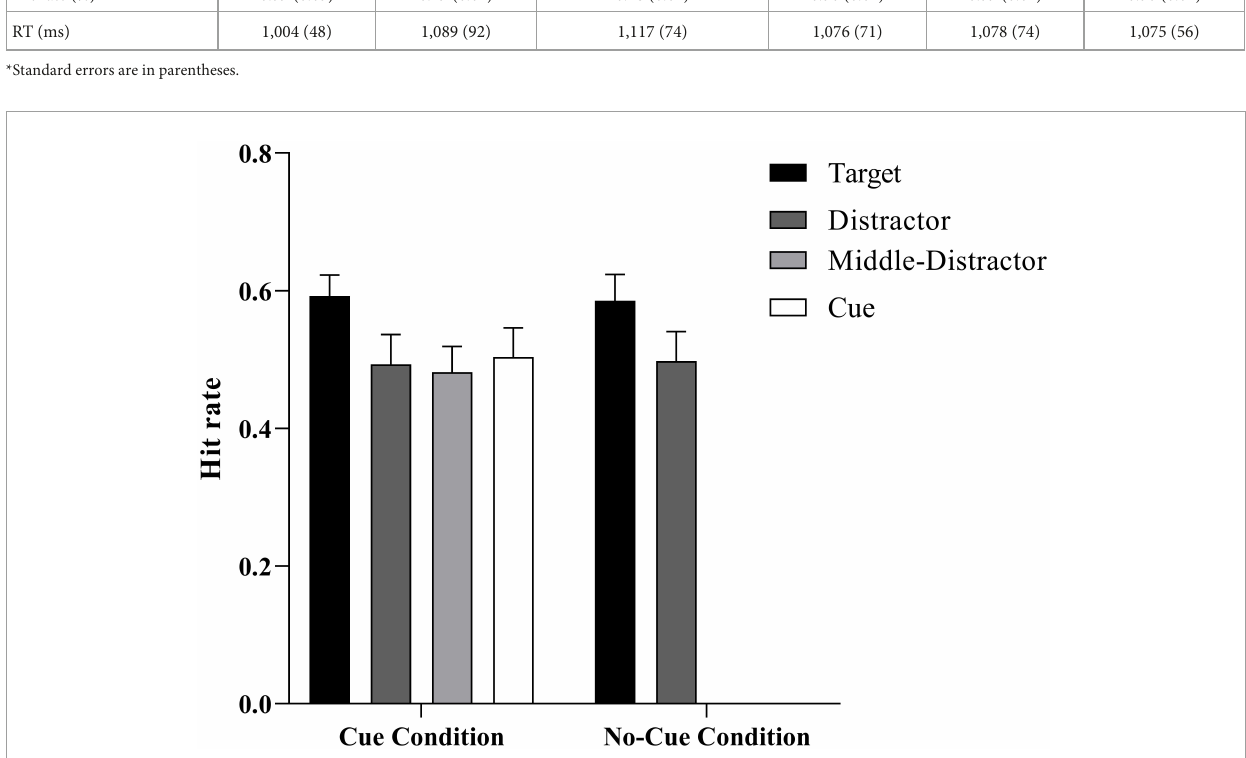
FIGURE4 Mean hit rate as a function of the stimulus type (target vs. distractor vs. middle distractor vs. cue) × condition (cue vs. no-cue). Error bars represent ± 1 SE of the mean.